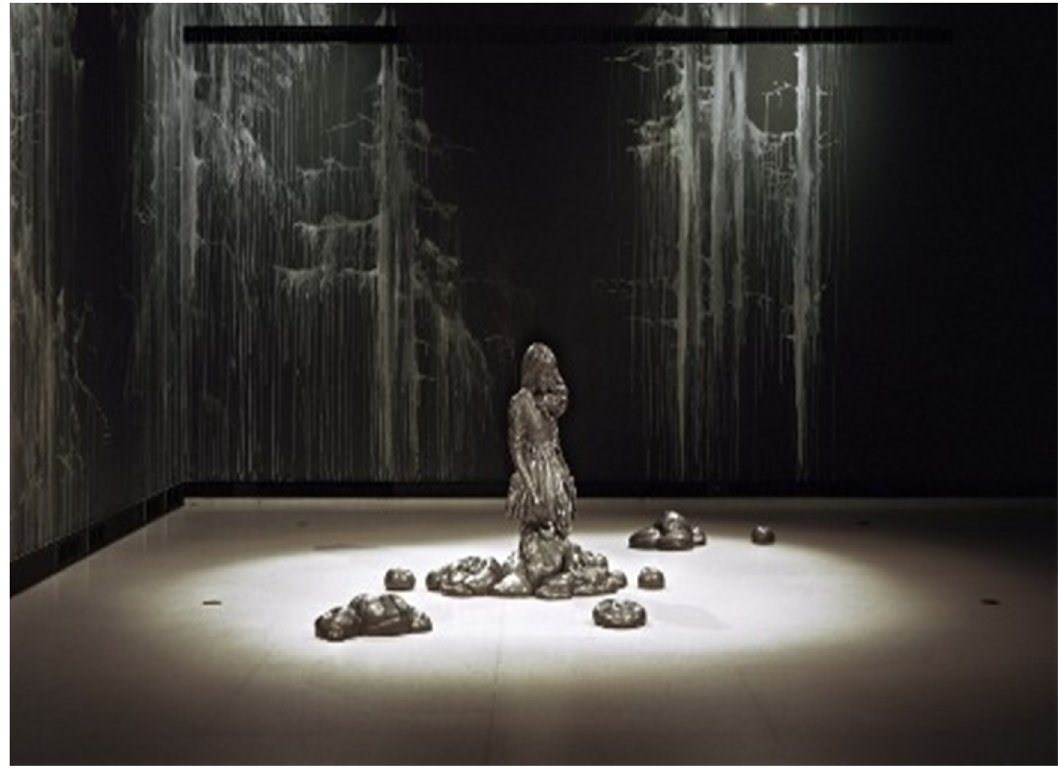
Figure 5: Anne Wenzel, “ Ophelia is not here, ” 2009, installation. https://joel7663.wordpress.com/2009/05/13/ophelia - is - not -